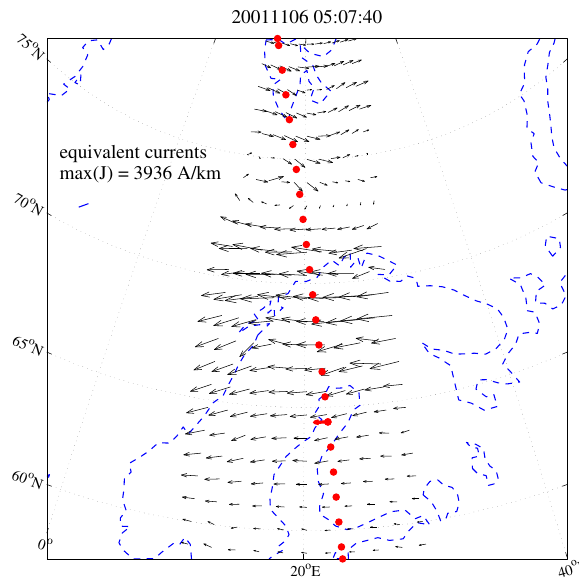
Fig. 4. Magnetograms of the IMAGE stations (for locations refer to Figure 1) of the storm event starting on 5 November 2001; B x component.